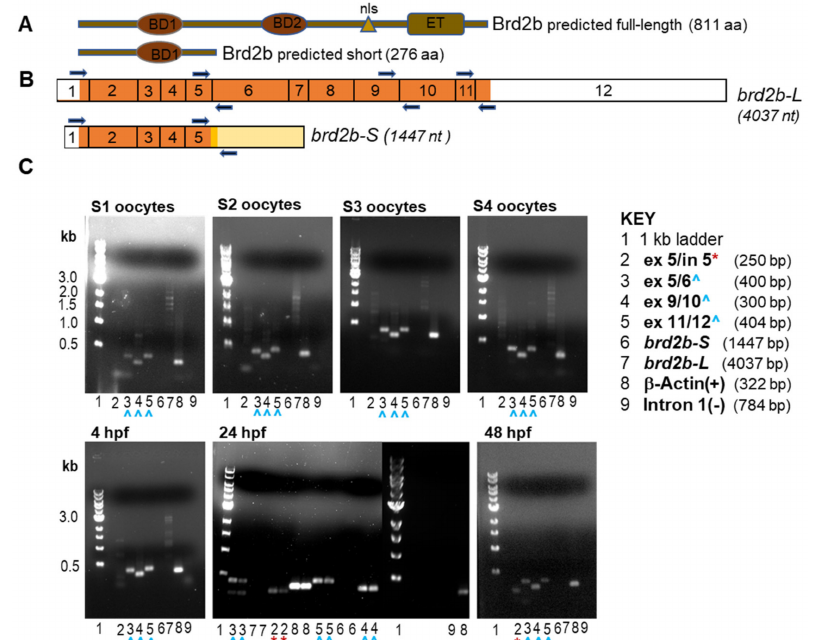
Figure 1. brd2b transcript variants are differentially regulated during development. ( A ) Schematic of predicted proteins from the brd2b locus, full-length Brd2b-L and truncated Brd2b-S. Bromodomains BD1 and BD2 (ovals), nuclear localization signal (NLS, triangle), and a C-terminal extraterminal (ET) domain (rectangle). ( B ) Schematic of the long ( brd2b-L ) and short ( brd2b-S ) transcript variants encoded by the brd2b locus, with numbered exons. UTRs of 5 (cid:48) and 3 (cid:48) are shown in white; protein-coding regions are shown in orange. The short transcript retains part of intron 5 (shown in yellow), which introduces a premature stop codon (darker yellow shows part of intron that is translated). Primer pairs flanking exon–exon junctions and used in RT-PCR are shown as dark blue arrows. ( C ) RT-PCR products produced from mRNA of staged oocytes (top gels) and 4, 24, and 48 hpf embryos (bottom gels), using various primer pairs, as shown in B. Lanes labeled with the same number display the PCR product obtained using the same primer pairs, as shown in the key: (1) 1 kb ladder (NEB); (2) ex5/in5 primers ( brd2b-S 250 bp predicted product); (3) ex5/6 primers ( brd2b-L 400 bp predicted product); (4) ex9/10 primers ( brd2b-L 300 bp predicted product); (5) ex11/12 ( brd2b-L 404 bp predicted product); (6) ex1/in5 primers (full-length brd2b-S 1447 bp predicted product); (7) ex1/ex12 primers (full-length brd2b-L 4037 bp predicted product); (8) primers for β -actin (+) control (322 bp predicted product); (9) primers internal to intron 1 (not shown in B), as ( − ) control for genomic DNA (784 bp predicted product). Maternal brd2b-L predicted PCR products are detected in all stages of ooctye tested (blue arrowheads, lanes labeled 3,4,5, top gels), but brd2b-S predicted products are not present (lanes labeled 2, top gels). The bands observed in stage 1, 2 and 3 oocytes in lanes labeled 2 are either smaller than the 250 bp predicted product for brd2b-S (s1, s2 gels), or are very faint products among several faint products (s3 gel), so are likely a spurious. Zygotic brd2b-S predicted product is detected in 24 hpf and 48 hpf embryos (red asterisk, lanes labeled 2, bottom gels), but not in 4 hpf embryos, while zygotic brd2b-L is detected in all stages of embryos tested (blue arrowheads, lanes labeled 3,4,5, bottom